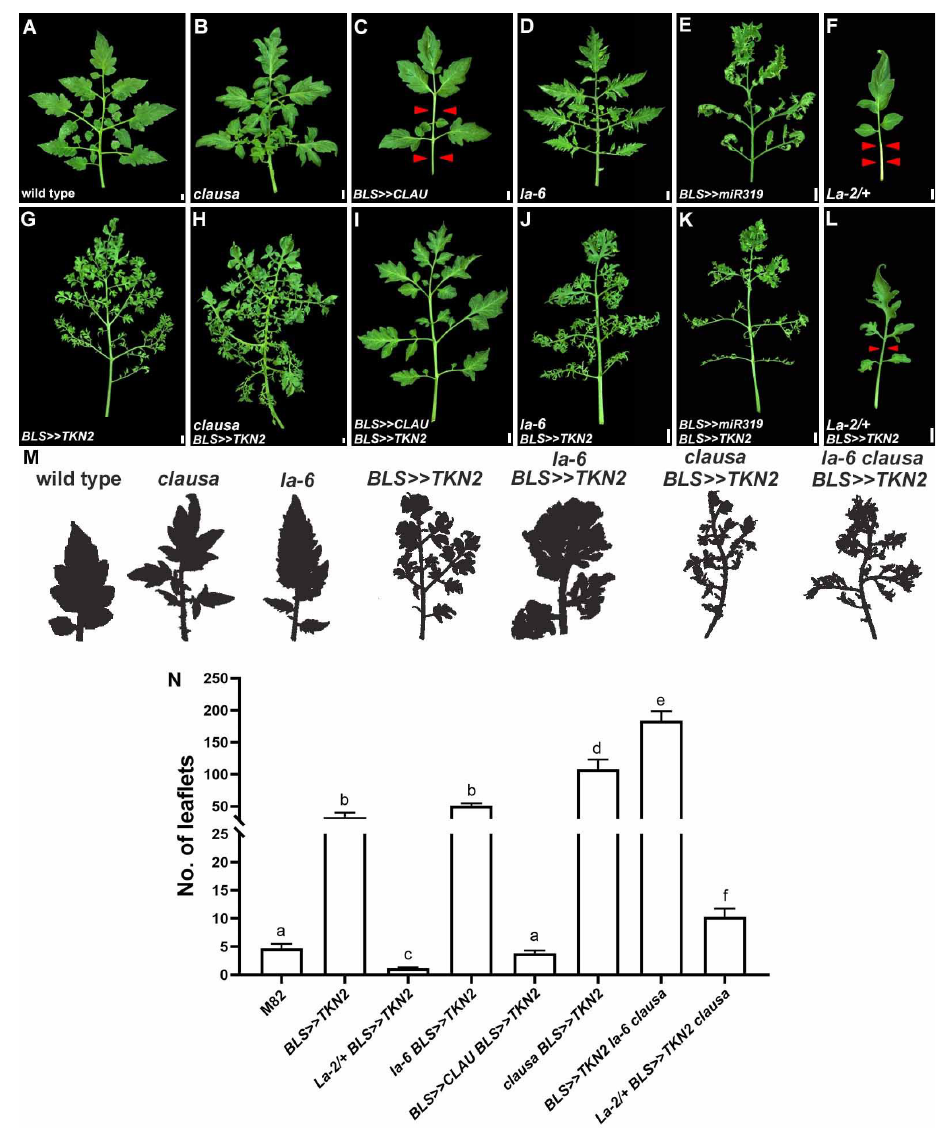
Fig 4. TKN2 promotes morphogenetic activity in altered CLAU and LA backgrounds. (A-L) Overexpression of TKN2 in the background of genotypes with altered CLAU and LA expression levels. All leaves depicted are fully expanded fifth leaves. Bars = 1 cm. Red arrowheads represent missing primary and intercalary leaflets. (M) Shaded cartoon of the terminal leaflet of the indicated genotypes. (N) Quantification of leaf complexity of the second left-hand lateral leaflet of leaf No. 5 upon overexpression of TKN2 in genotypes with altered CLAU and LA expression levels. Graphs represent mean ± SE of at least three independent biological repeats. Letters indicate significant differences between samples in a one-way ANOVA with a Tukey post-hoc test, p < 0.027.